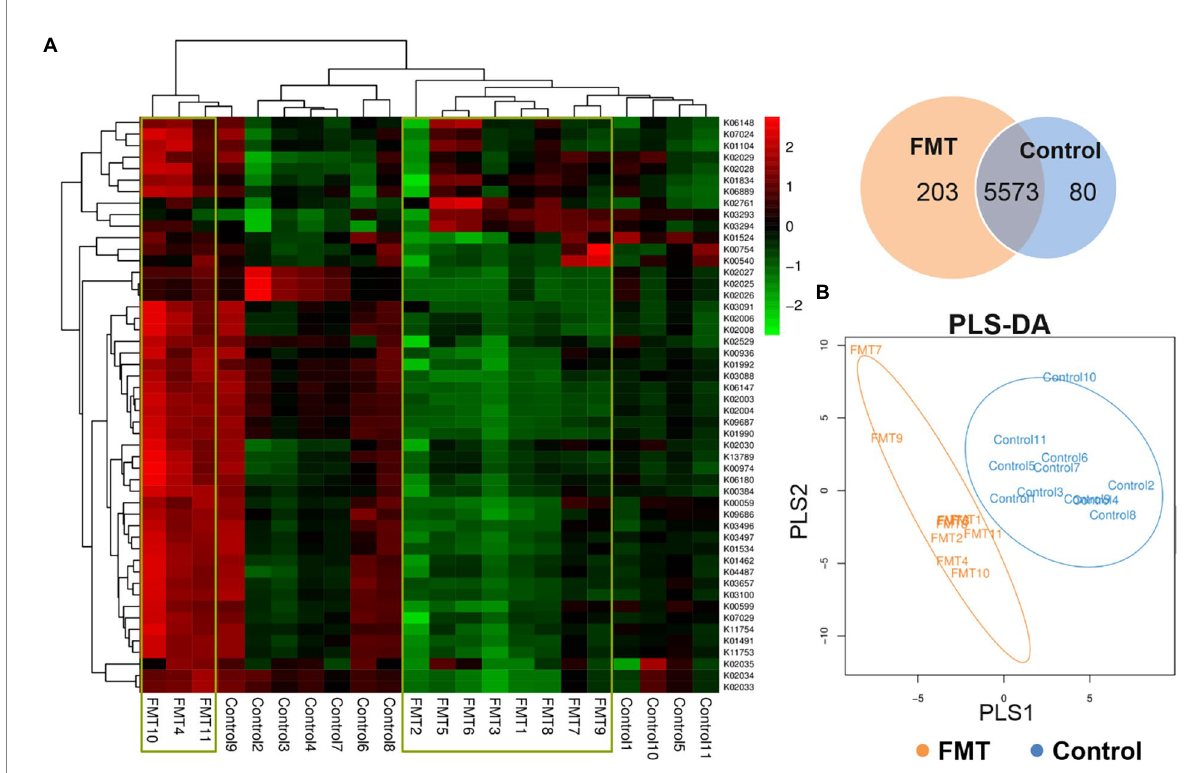
FIGURE 4 Effect of FMT on Functional Prediction of KEGG Second-level Analysis. (A) KEGG orthologous gene cluster abundance heat map combined with cluster analysis based on the similarity of the functional group abundance distribution between samples (red represents a functional group with higher abundance in the corresponding sample, and green represents a functional group with lower abundance); venn diagram of the common and unique functional group, (B) PLS-DA discriminant analysis plot showed samples belonging to the same group are closer to each other, and the distance between the points of different groups is